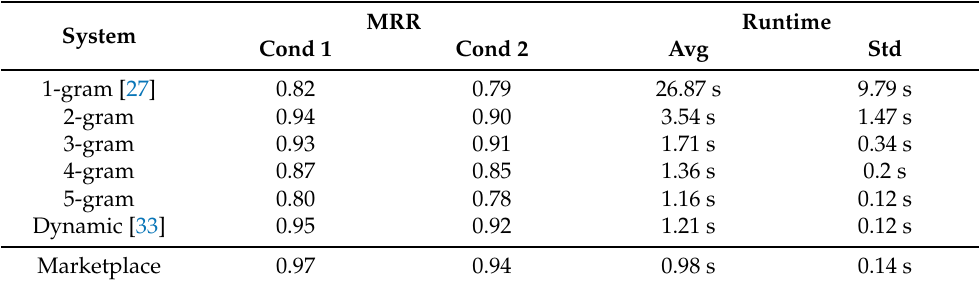
Table 2. Experimental results on the scan-based sheet music retrieval task. Each query is a digital scan of piano sheet